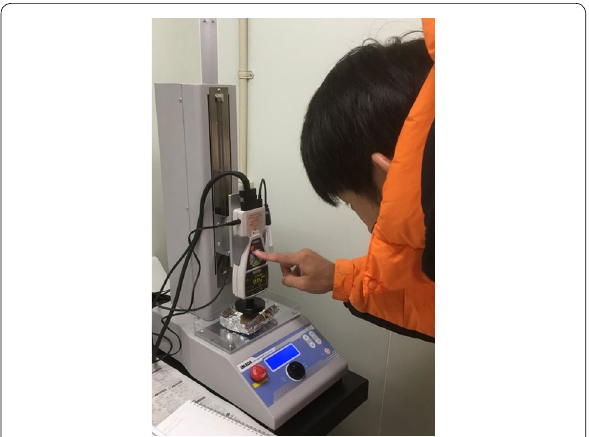
Fig. 2 Photographs of the resulting mixture. Mixture removed onto a sieve after rotating the pot: a soft sherbet-like mud and b harder aggregate consisting of tephra, water, and snow